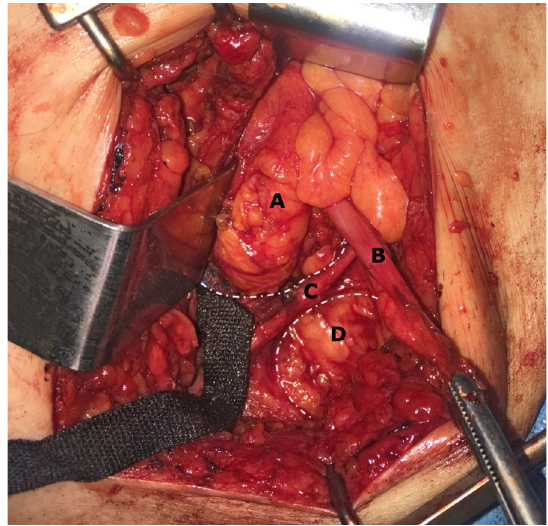
Fig. 1 Anterior view of the left inguinal region after dissection and opening of the direct inguinal hernial sac. Gauze was inserted to partially reduce its contents to the abdominal cavity during dissection. A cecum, B appendix, C inguinal ligament, D femoral hernia. The dashed dot indicate the boundaries of the inguinal and femoral hernia defects